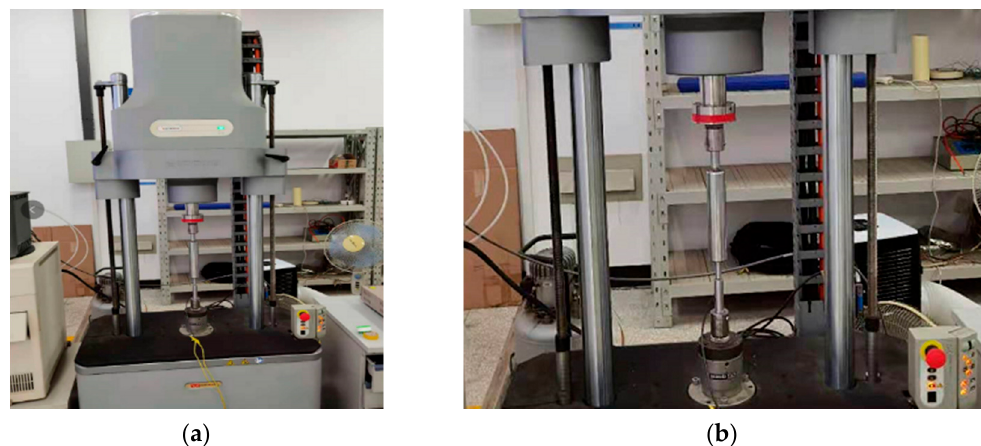
Figure 3. Damping characteristics test of the magnetorheological fluid damper. ( a ) Instron E10000 electronic dynamic testing machine; ( b ) MRF damper installed on the dynamic testing machine.